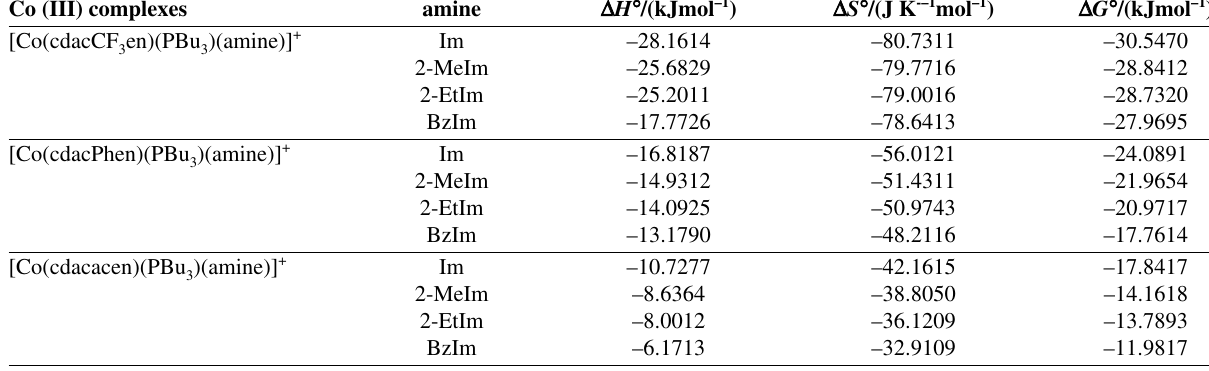
Table 6. The computational Thermodynamic parameter values, Δ H ° , Δ S ° and Δ G ° for Co(III) Schiff base complexes with various cyclic amines in gas